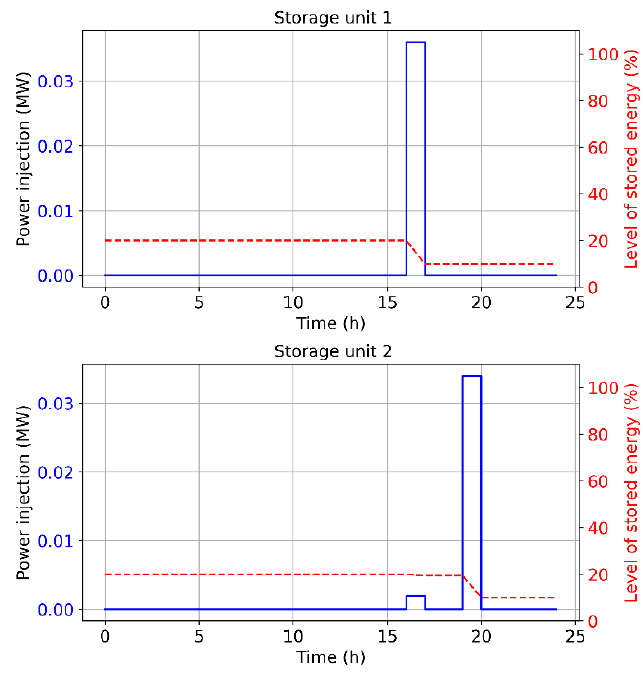
Figure 4. Results obtained from the proposed methodology for the second scenario.